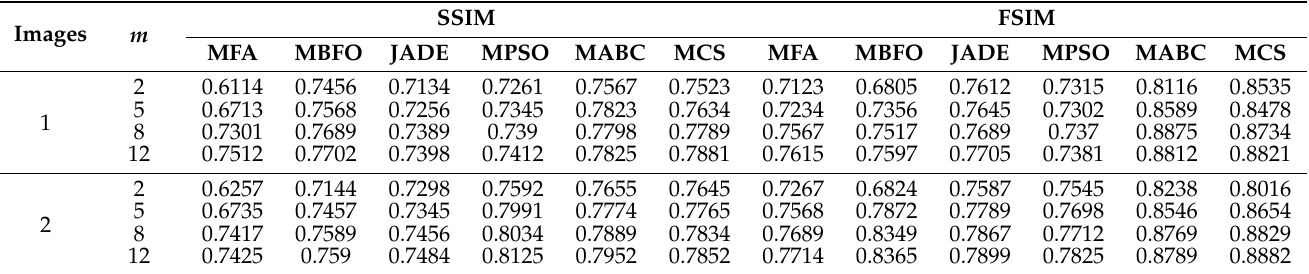
Table A3. Comparison of SSIM and FSIM computed by different algorithms using the EC-Otsu method.